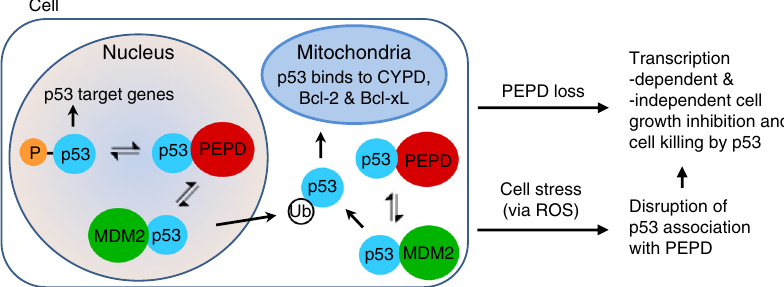
Fig. 10 Paradigm of p53 regulation by PEPD. PEPD binds to both nuclear and cytosolic p53. More than 50% of cellular p53 is sequestered by PEPD, rendering cells dependent on PEPD for survival and growth under normal circumstances, as eliminating PEPD activates p53, which leads to cell death. PEPD binds to nuclear p53 to inhibit its phosphorylation and transcription activity. PEPD competes with MDM2 for p53 binding, thereby inhibiting MDM2- dependent mitochondria translocation of nuclear and cytoplasmic p53, leading to inhibition of transcription-independent activity of p53. The PEPD-p53 complex is designed for rapid mobilization of pre-synthesized p53 in response to stress, which is mediated by ROS. Notably, MDM2 is known to promote p53 translocation to mitochondria by monoubiquitinating p53, to promote p53 degradation by polyubiquitinating p53, and to inhibit p53 transcription activity unrelated to ubiquitination. It is also known that the MDM2 gene is transcriptionally activated